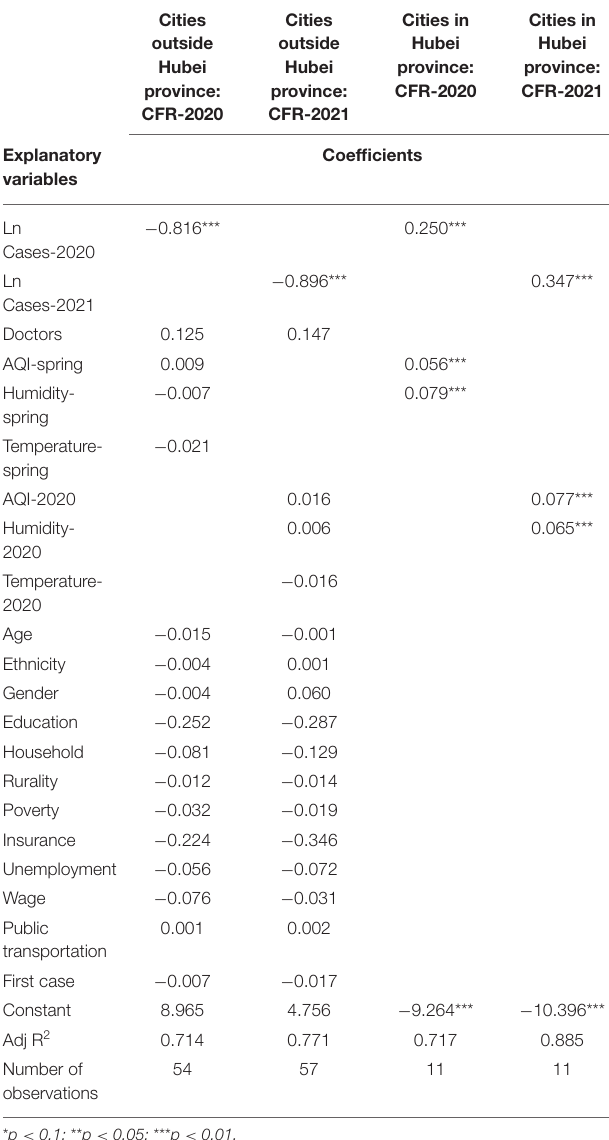
TABLE 4 | Second part: Log-linear regression estimates for cities with nonzero case fatality rate